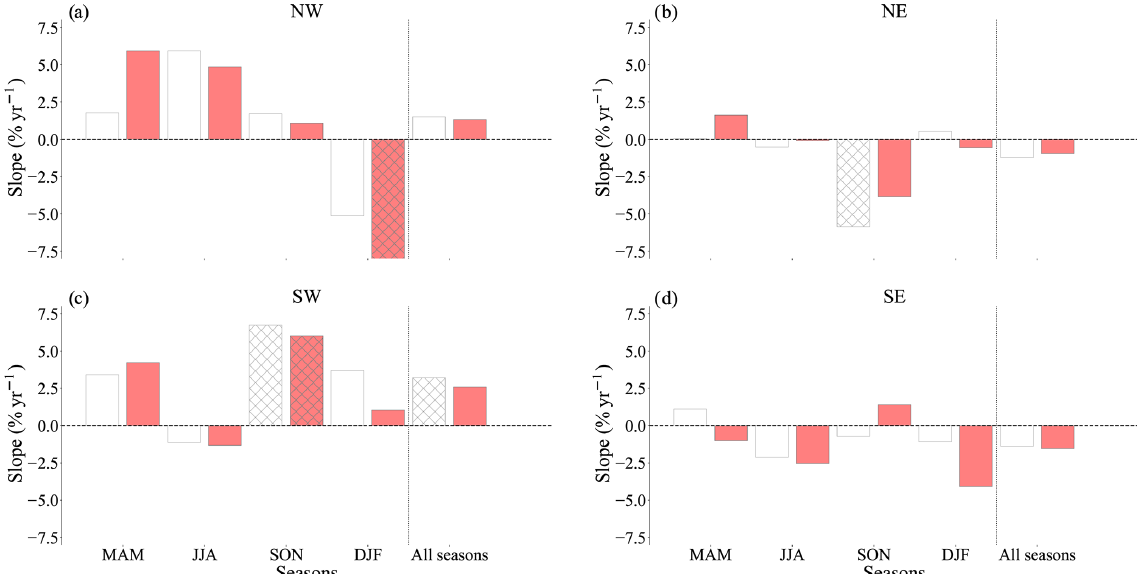
Figure 5. Relative trends in monthly contributions from each respective region: (a) north-west (NW), (b) north-east (NE), (c) south-east (SE), and (d) south-west (SW). The white bar displays the Theil–Sen estimator (TS); the red bar displays log-transformed least mean square (LMS) trends. Cross-hatching denotes trends that are statistically significant at a confidence interval of 95%. The dashed line aids the reader in separating the individual seasonal trends and the trend with all the seasons included.